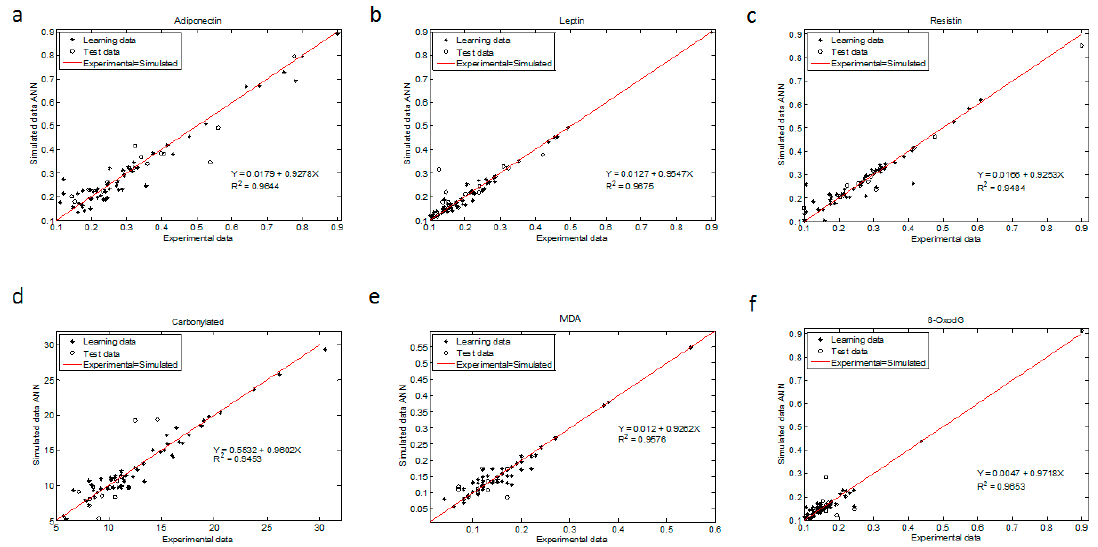
Figure 2. Experimental vs. ANN-simulated values for blood adipokine and oxidative marker concentrations. Scatter plots of: ( a ) adiponectin; ( b ) leptin; ( c ) resistin; ( d ) carbonylated proteins; ( e ) MDA; and ( f ) 8-oxodG maternal levels. Red lines indicate the linear regression model on scatter points. Open circles and closed diamonds depict experimental data and learning data, respectively.